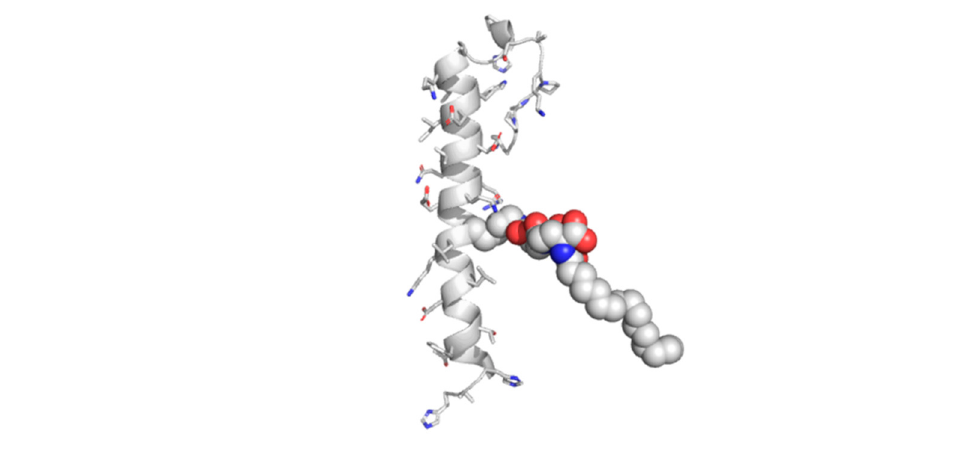
Figure 1. Amino acid sequence and modeled three-dimensional structure of the peptide. Aib is a 2-aminoisobutyric acid residue and dAla is a D-alanine. Residue 14 is modified by addition of a C16 fatty acid (palmitic acid) at the ε -amino group of lysine using two γ -glutamic acid spacers.